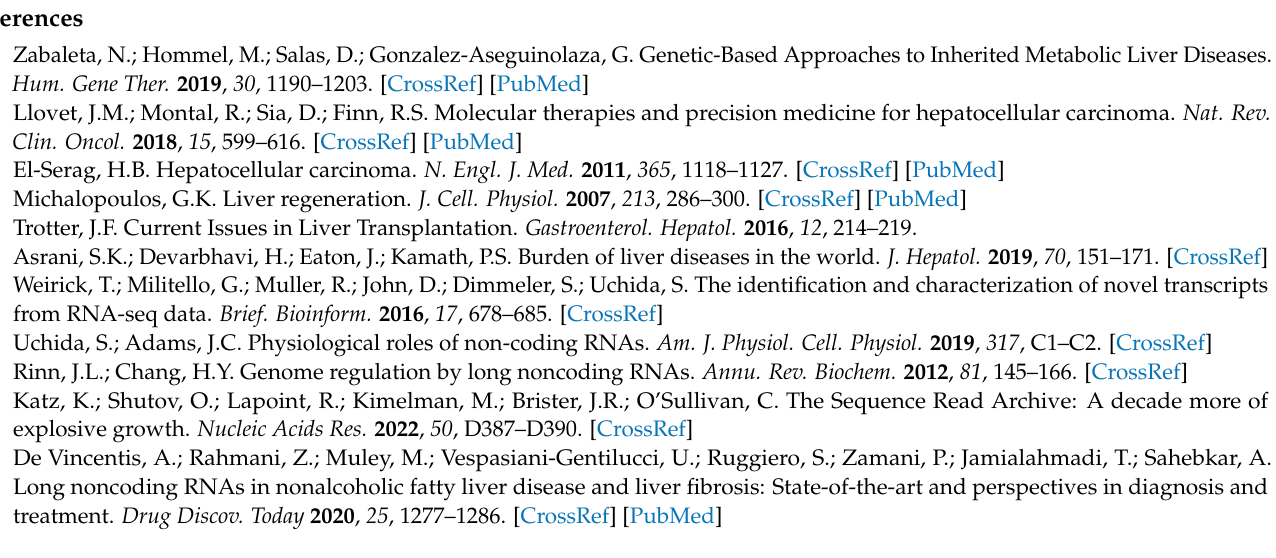
Differentially expressed protein-coding